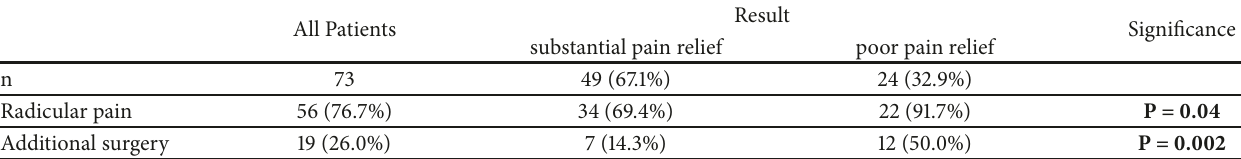
Table 3: Patient characteristics dependent on the outcome and significant differences between these two groups. All